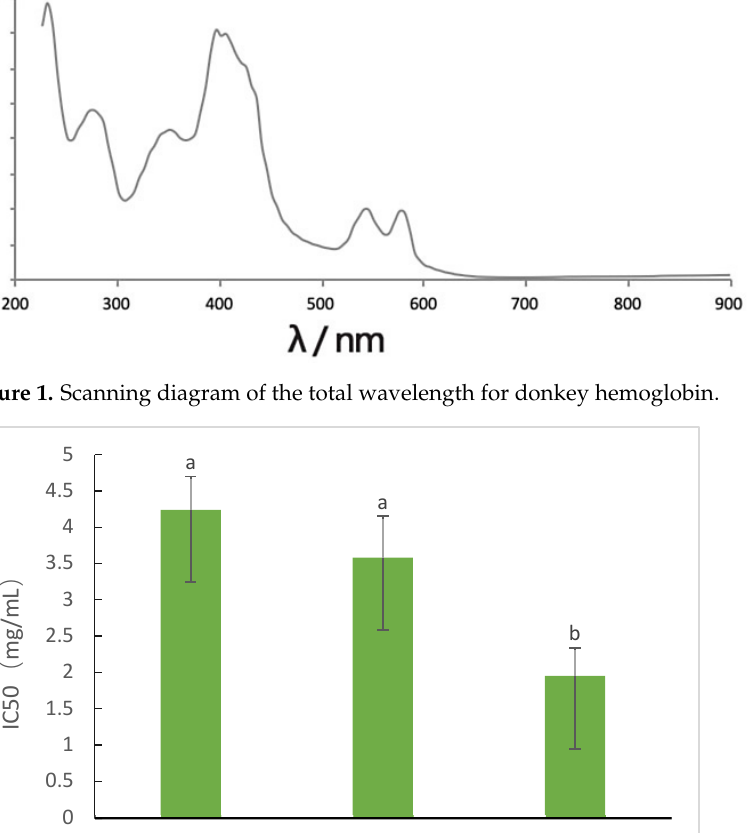
Figure 1. Scanning diagram of the total wavelength for donkey hemoglobin.